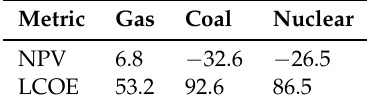
Table 11. Expected NPV and LCOE values.